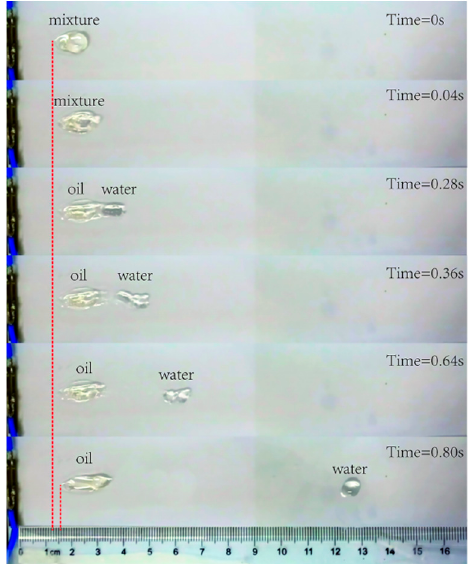
Figure 8. Test on glass substrate. Top view of separation of an oil/water mixed drop. The waves are propagating from left to right. Reproduced from Ref. [89]. The same results are obtained in the test on the steel substrate (shown in Figure 9).